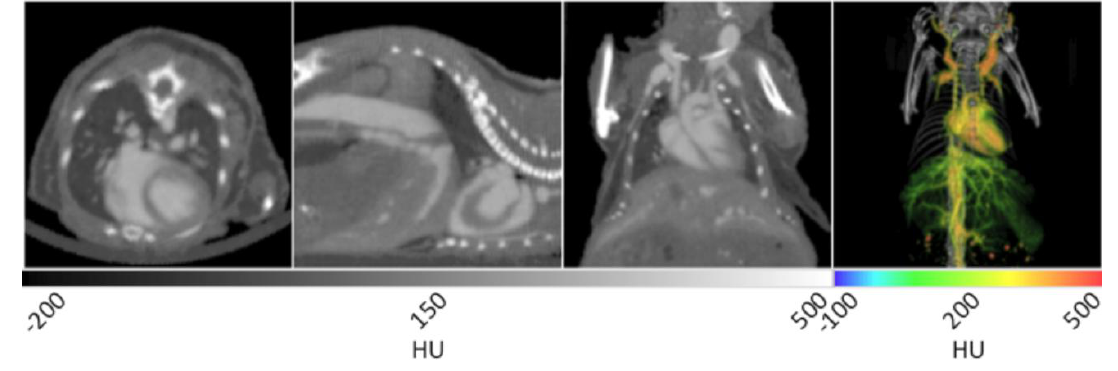
Figure 4. X-ray CT data of murine vasculature with AuroVist™ contrast enhancement. In the first three panels, the vasculature appears much brighter than the surrounding tissue due to the high concentration of gold nanoparticles in the blood. The contrast enhancement enables the visualization the heart, the aorta, and carotid arteries in addition to very fine vasculature in most organ systems. The right panel displays a 3D rendering in which the vasculature has been given a rainbow intensity scale to highlight its breadth in the heart, liver and